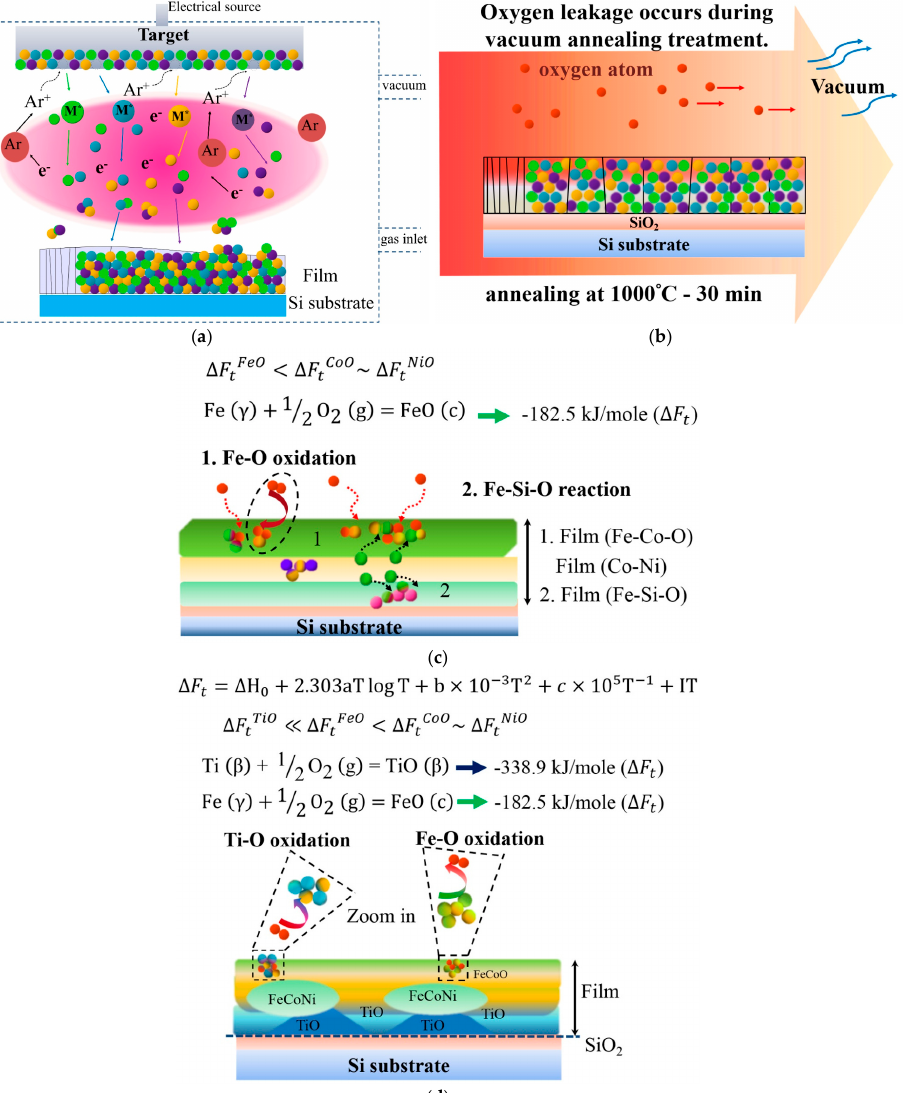
Figure 6. Schematic diagram showing the formation of phases in Ti x FeCoNi films from the as-deposited state to the post-annealed state: ( a ) DC sputtering deposition of thin film on Si substrate; ( b ) oxygen coming from the vacuum chamber and SiO 2 substrate during vacuum annealing; ( c ) diffusion pathways and layer formation in Ti 0 film during annealing; and ( d ) diffusion pathways and layer formation in Ti 0.5 and Ti 1.0 films during